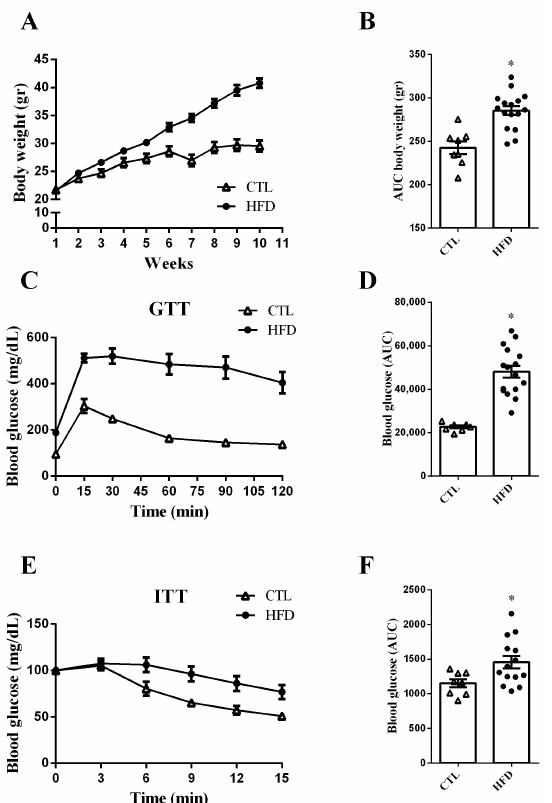
Figure 1. HFD increases body weight gain and impairs glucose tolerance and insulin sensitivity in mice. Body weight over the course of the experimental period ( A ) and its respective area under the curve (AUC) ( B ) of CTL and HFD mice (n = 8–16). Blood glucose of CTL and HFD mice during the intraperitoneal glucose tolerance test (ipGTT) ( C ) (n = 8–16). The area under the curve (AUC) of total blood glucose concentration of CTL and HFD mice during ipGTT ( D ) (n = 8–16). Blood glucose of CTL and HFD during the intraperitoneal insulin tolerance test (ipITT) ( E ) (n = 8–14). The area under the curve (AUC) of total blood glucose concentration of CTL and HFD during ipITT ( F ) (n = 8–14). Data are the mean ± SEM. * p ≤ 0.05 (Student’s t -test).